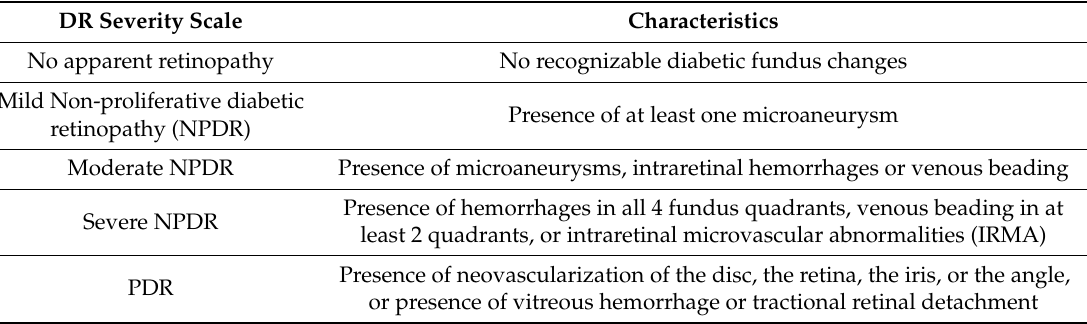
Table 6. International Clinical Disease Severity Scale for DR